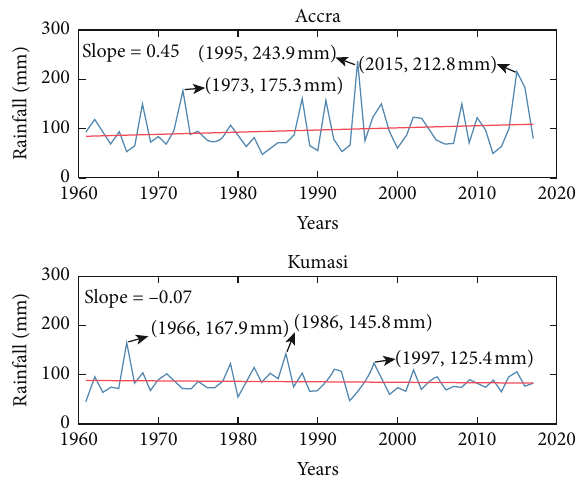
Figure 7: ADMR (1961–2017). Rainfall variability over Accra and